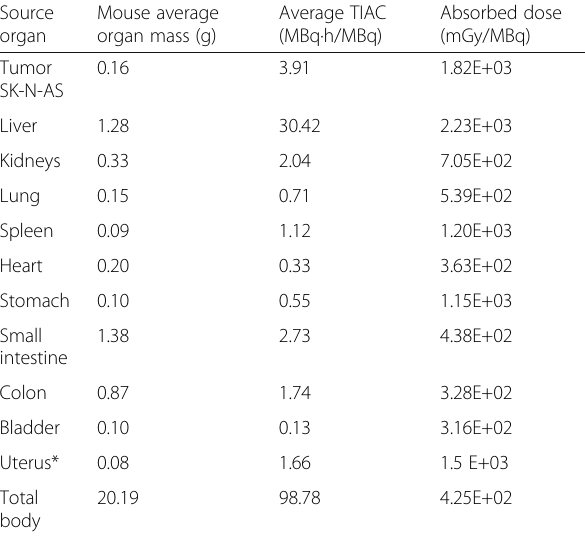
Table 4 Mouse dosimetry of [177Lu]Lu-1C1m-Fc. These estimates come from mouse TIACs calculated from source organ time-activity